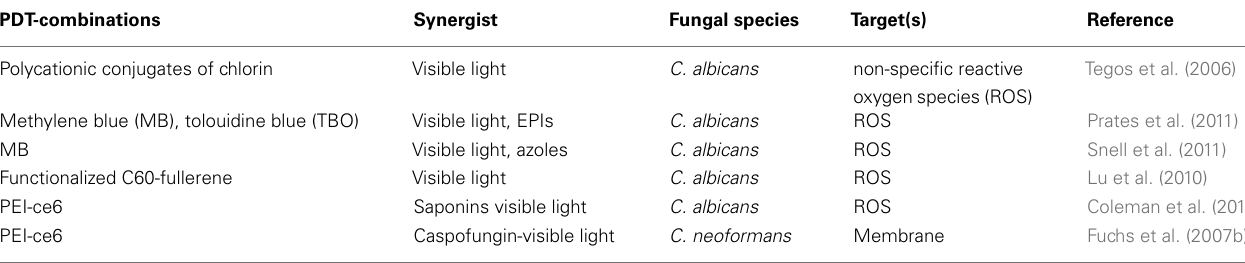
Table 1 | Photodynamic therapy-based combinations: potential antifungal countermeasures.